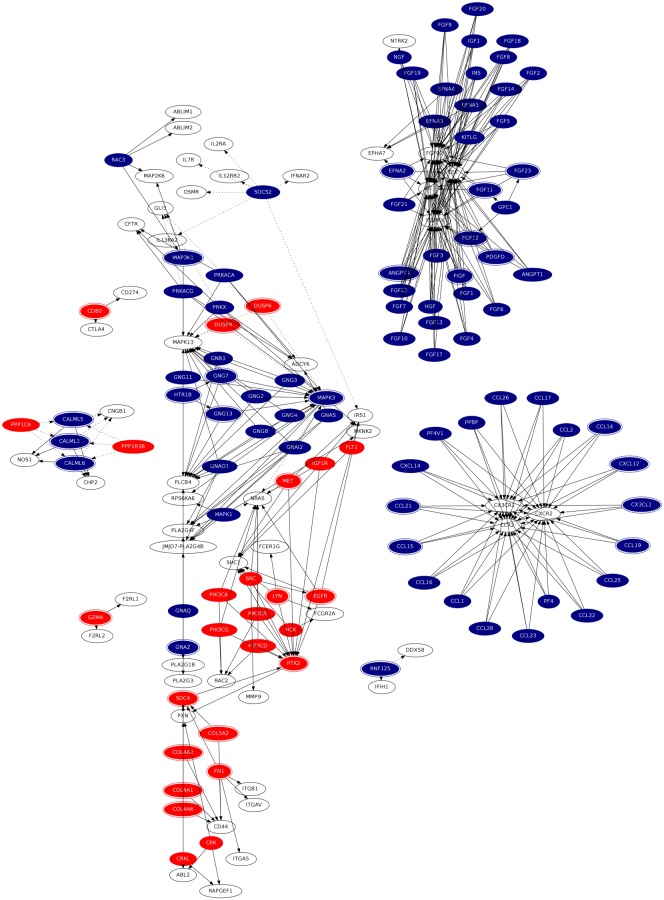
The Consolidated Causal Network.The genes are depicted as nodes of causal network. The hypotheses genes are distinctly colored as ‘red’ or ‘blue’ representing their over- or under-expression respectively, observed in study dataset. Relationships are depicted as edge or arrow in causal network. The solid arrow represents ‘activation’ relationship between connected nodes, whereas dashed arrow represents ‘inhibition’ relationship between the connected nodes. The node which has been identified as hypothesis gene, and also downstream gene for some other hypothesis, has been marked with an extra peripheral surrounding.